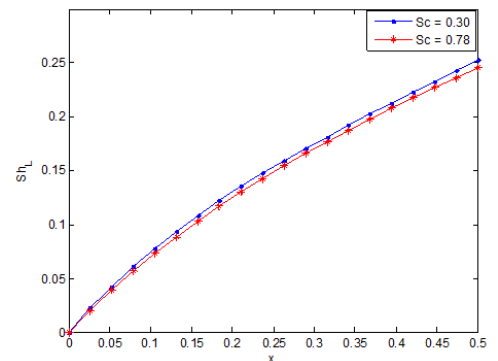
Figure 27. Effects of Schmidt number on Sherwood